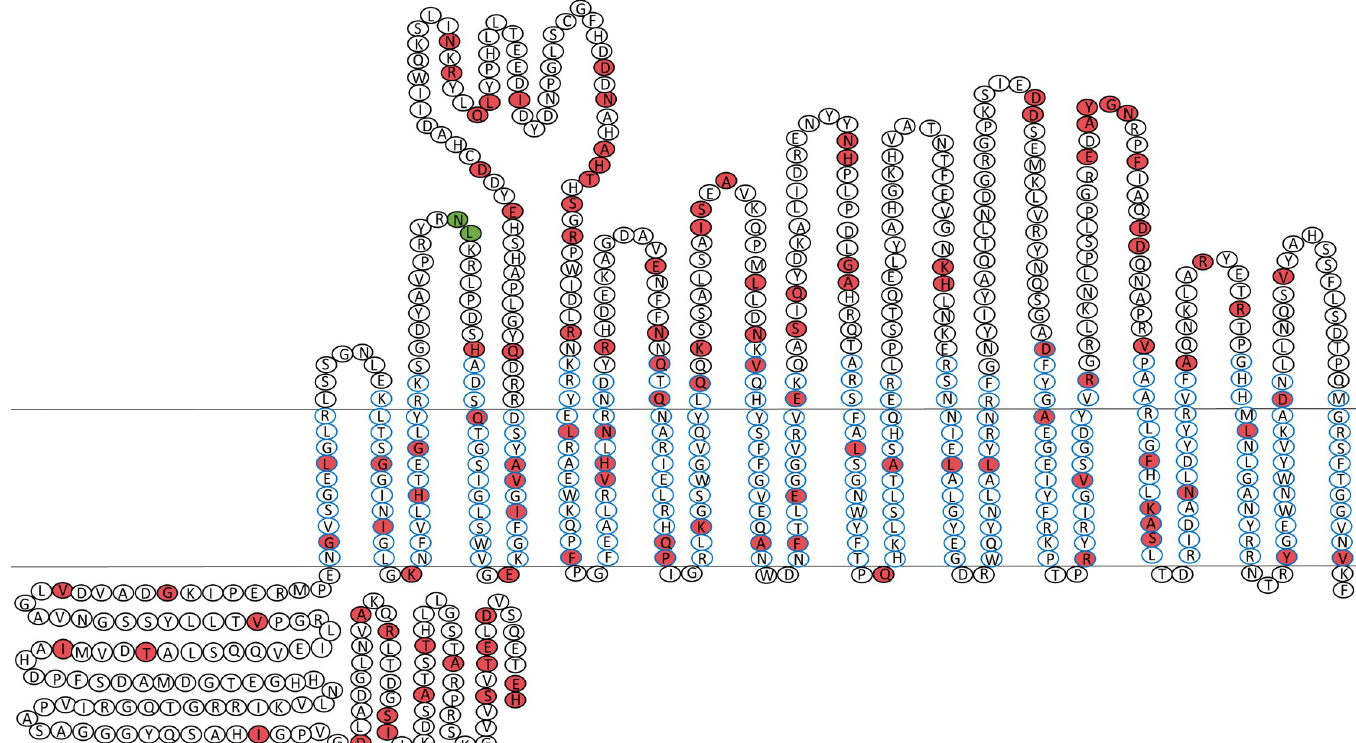
Fig 2. Predicted topology and conservation of TdfJ and its homologues. Amino acid sequences for 50 examples of gonococcal TdfJ or its homologue in N . meningitidis , N . lactamica , or N . elongata (accession numbers are available in the Materials and Methods) were aligned using Geneious and submitted to NetSurfP-2.0 for prediction of transmembrane domains and intra-/extracellular loops. This information was used to create a topology prediction in TOPO2, which was then adapted to create the above model, which has the protein’s cleavable N-terminal signal sequence removed. The two horizontal lines represent the outer membrane, and each amino acid residue of the protein is represented by a circle. Residues in white are identical across all 50 sequences, while those in red have 1 or more mismatches, and the most common residue is indicated. Residues outlined in blue make up β sheets. Two residues are shown in green. These two residues are variable, and 9 of the 50 sequences queried contain a conserved KEEG motif between these two residues. The sequences tested showed 96.2% pairwise identity, with 82.9% of residues being identical in all cases.